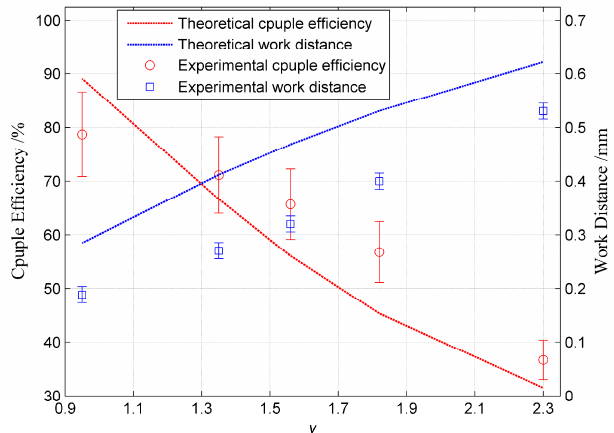
Figure 7. Theoretical and experimental working distance and maximum coupling e ffi ciency versus γ .